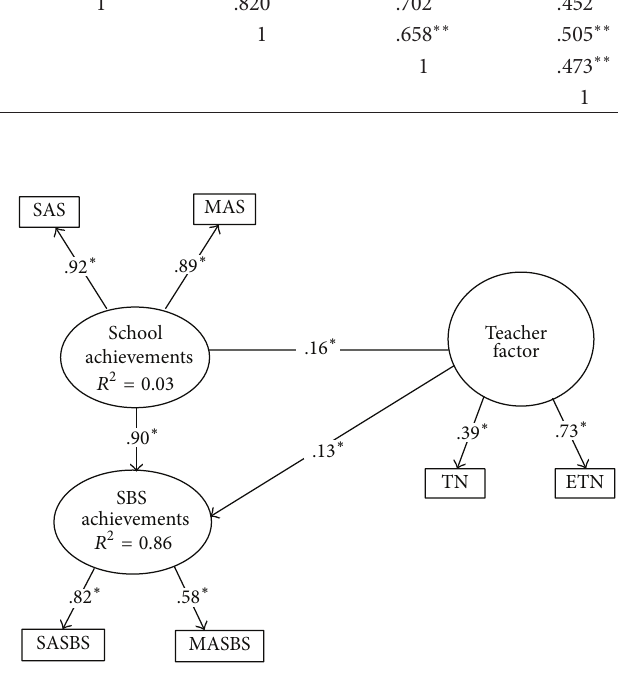
Figure 2: The effects of teacher factor on students’